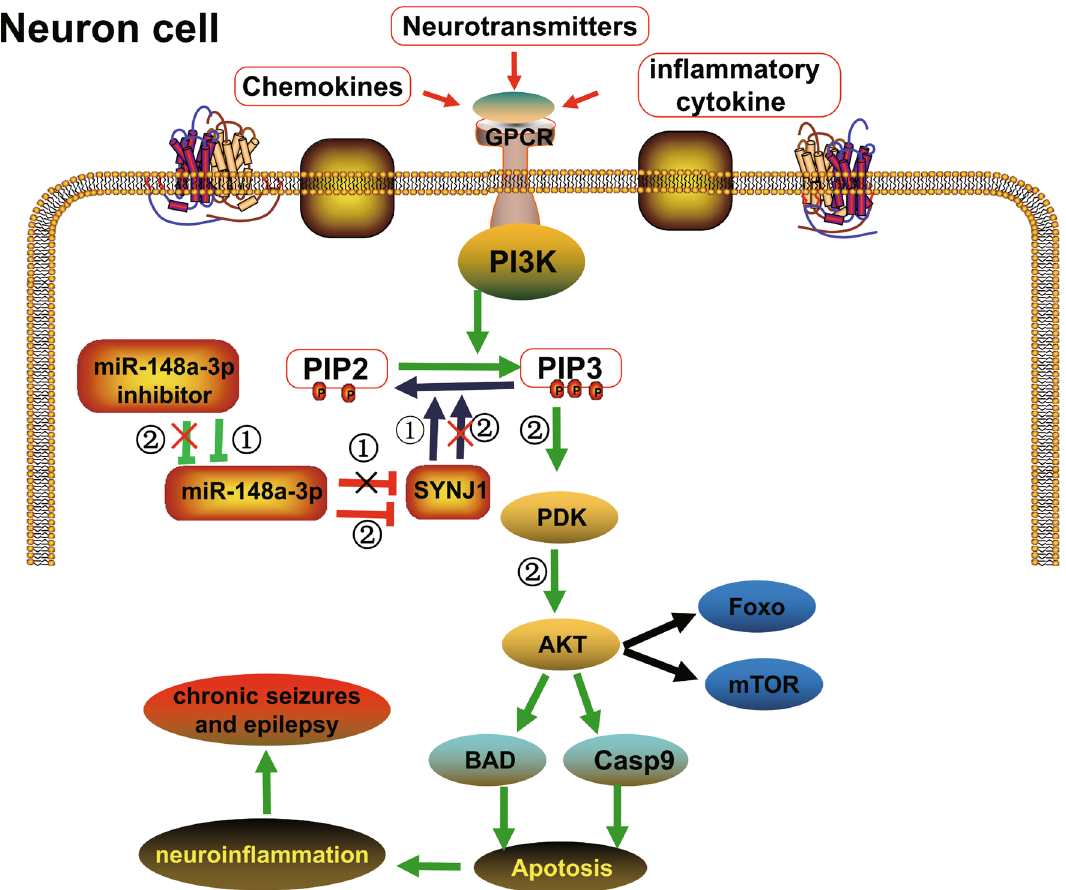
Figure 10. Schematic of the proposed hypothesis model showing that miR-148a-3p positively regulates neuronal apoptosis via activating the PI3K-AKT signaling pathway by targeting SYNJ1. In chronic seizure or epilepsy tissue, neurons and astrocytes and even microglia may be affected by neurotransmitters, chemokines and inflammatory cytokines. Furthermore, activation of the PI3K-AKT signaling pathway play a central role in the process of the apoptotic death of neural cells and causes neuroinflammation, which eventually leads to seizures or epilepsy. Mir-148a-3p inhibitor can inhibit the expression of mir-148a-3p, thereby increasing the expression of the SYNJ1 gene, making dephosphorylating PIP3 into PIP2, inhibiting PI3K-AKT signaling pathway, and reducing cell apoptosis. Conversely, upregulation of miR-148a-3p could enhance the PI3K-AKT mediated apoptosis pathway and neuroinflammation and then cause neuroinflammation, leading to seizures and